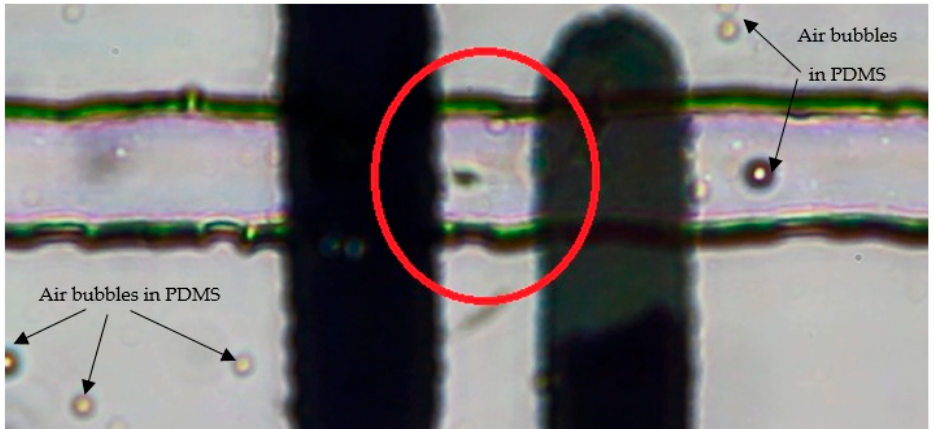
of times which the motile sperm signals were detected within 90 s.